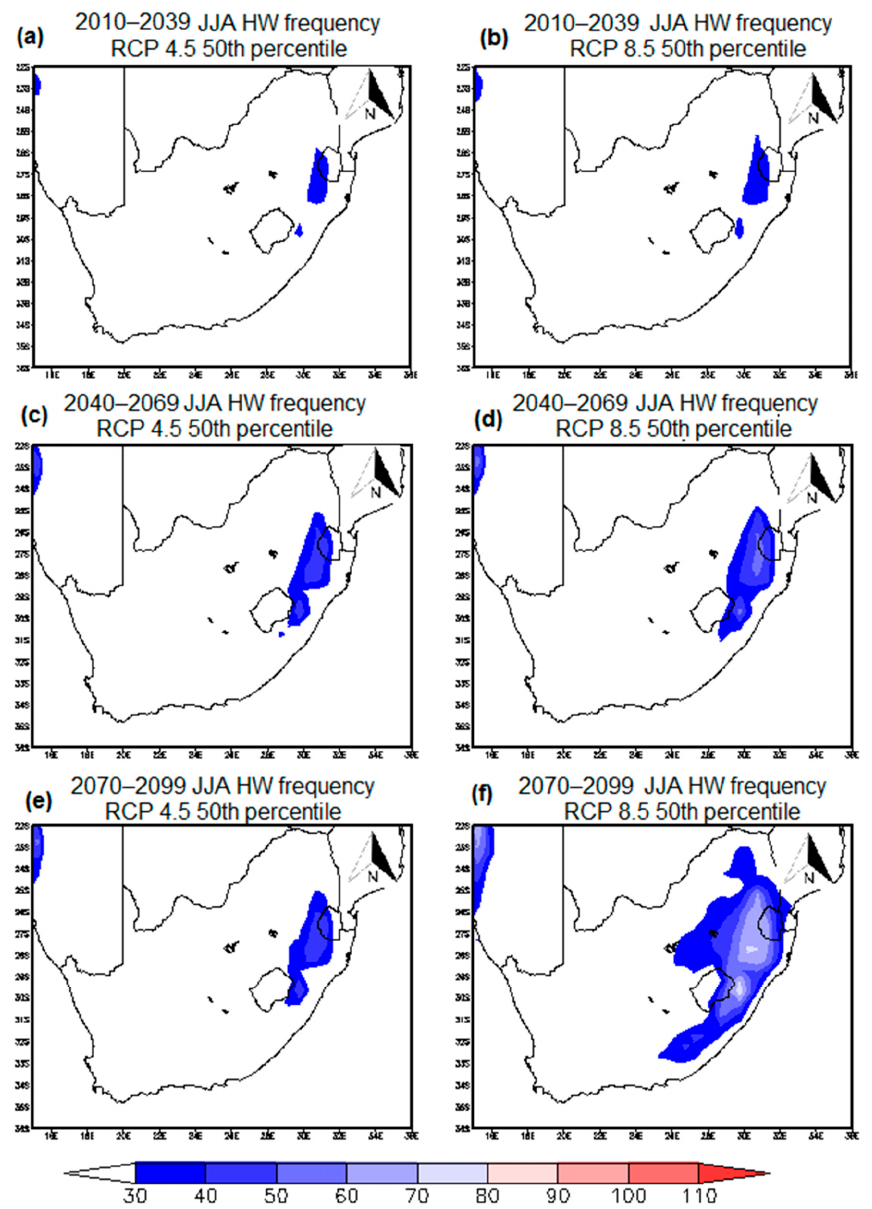
Figure 8. Simulations of JJA HW frequency (total number of occurrence) 50th percentile for ( a ) 2010–2039 RCP 4.5, ( b ) 2010–2039 RCP 8.5, ( c ) 2040–2069 RCP 4.5, ( d ) 2040–2069 RCP 8.5, ( e ) 2070–2099 RCP 4.5 and ( f ) 2070–2099 RCP 8.